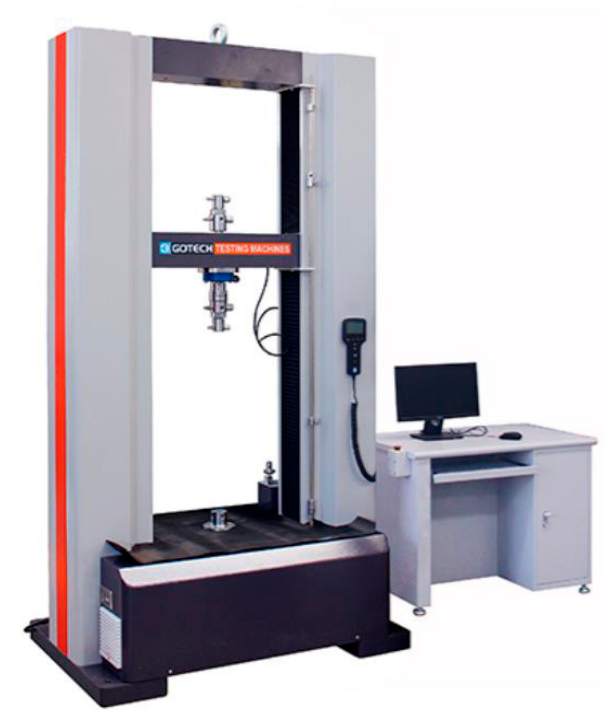
Figure 11. Creep testing machine.